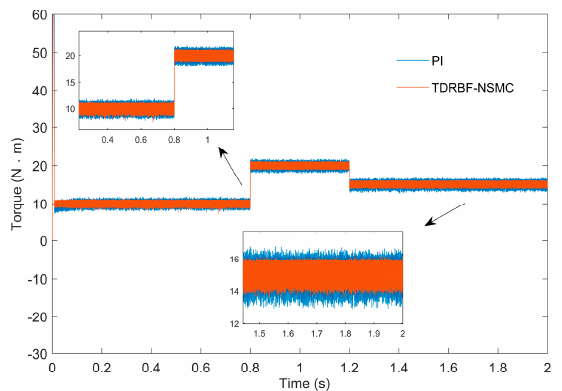
Figure 9. The current variation waveform of the TDRBF-NSMC.